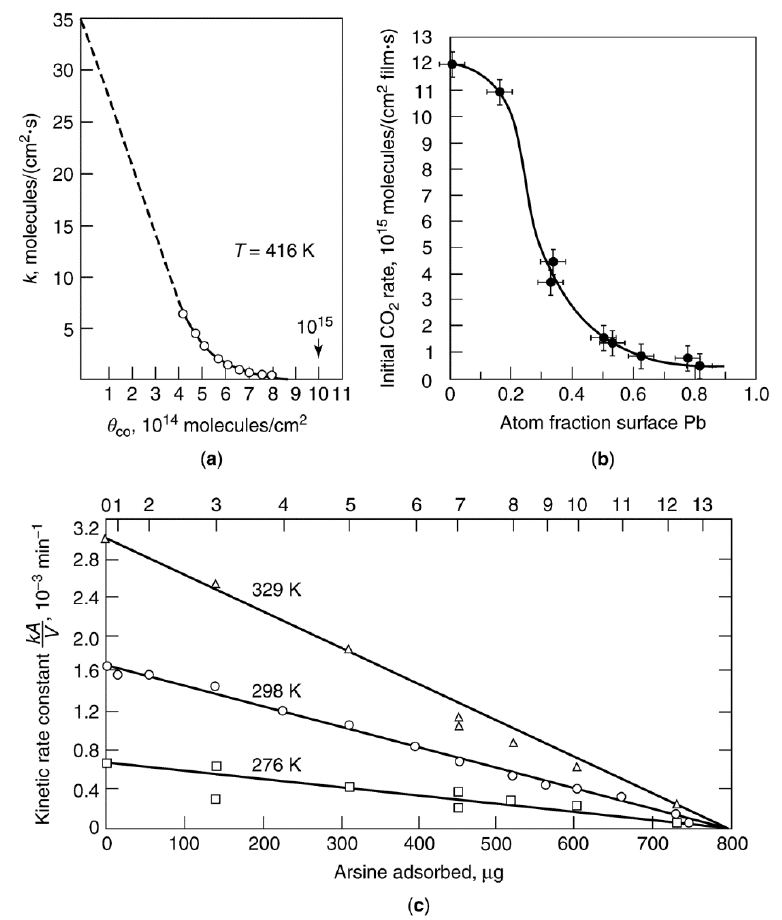
Figure 3. ( a ) CO poisoning of para-H 2 conversion over a Pt foil, reproduced from [24], copyright 1974, Wiley-VHC; ( b ) effect of lead coverage on the rate of CO oxidation of Pt film, reproduced from [25], copyright 1978, Elsevier; ( c ) rate constants of